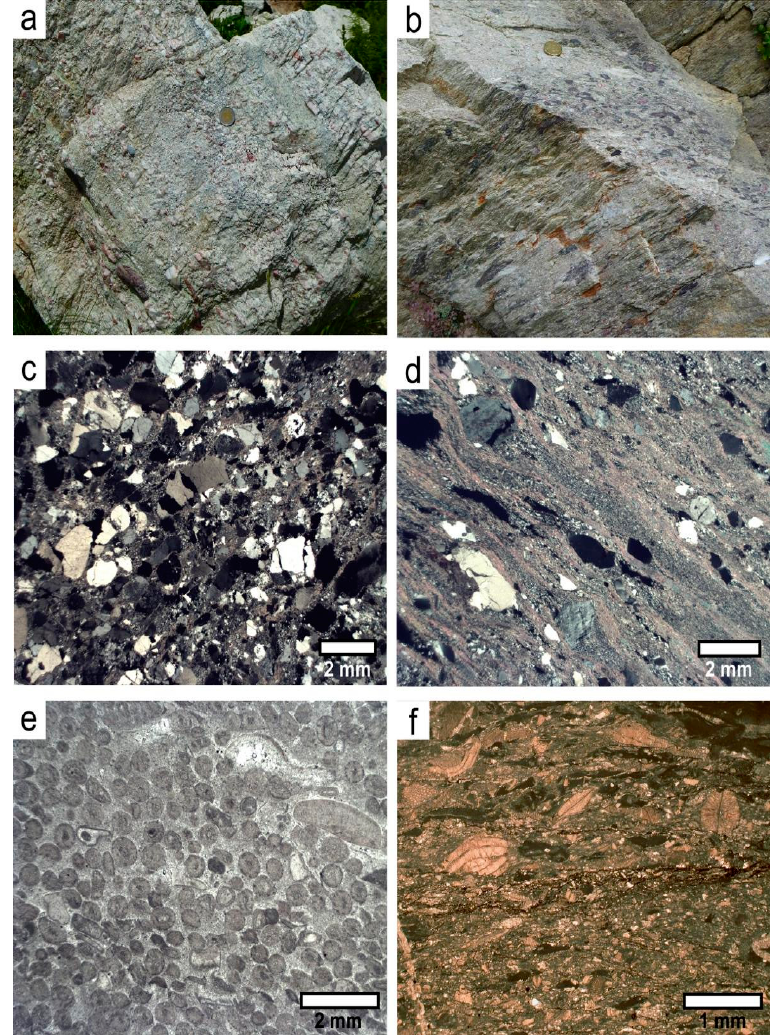
Figure 6. ( a ) Permian (?)-Early Triassic interbedded conglomerates and sandstones made up mainly of quartz and volcanics clasts. External Briançonnais Domain (Viridio Unit), Fauniera Pass area. ( b ) Permian (?)-Early Triassic quartzitic-rhyolitic metaconglomerate and metasandstone, Internal Briançonnais Domain (near Preit village), showing isooriented and stretched clasts that mark a gneissic structure. ( c ) Transmitted-light, crossed polars photomicrograph of sample PRV (external Briançonnais Domain, Fauniera Pass area; location in Figure 5), a coarse lithic sandstone corresponding to the finer levels of Figure 7a. A poorly defined lamination is evidenced by grain size variations. ( d ) Transmitted-light, crossed polars photomicrograph of sample SRV (internal Briançonnais Domain, Preit Valley; location in Figure 5), a metalithic sandstone corresponding to the finer levels of Figure 7b. A well-defined foliation is evidenced by the iso-orientation of the arenitic grains and by the occurrence of sub-millimetre thick levels of neoblastic iso-oriented white mica. ( e ) Transmitted-light photomicrograph of sample PRE 6 (Rocca la Meja tectonic slice, near the GVZ inner boundary, location in Figure 5), a dolomitized grainstone with oolites, echinoderm fragments and other bioclasts. Note the well-preserved morphology and internal structure of the oolites. ( f ) Transmitted-light photomicrograph of bioclastic arenaceous limestone (Eocene Nummulitic Limestone, Alpine Foreland Basin succession) from a tectonic slice within the LIVZ, Lago dei Signori pass, Marguareis area. Although a mm-scale foliation is present, evidenced by pressure dissolution seams and cataclastic levels, no volumetric dissolution or recrystallization occurred, as documented by the very well-preserved macroforaminifera and bryozoan.